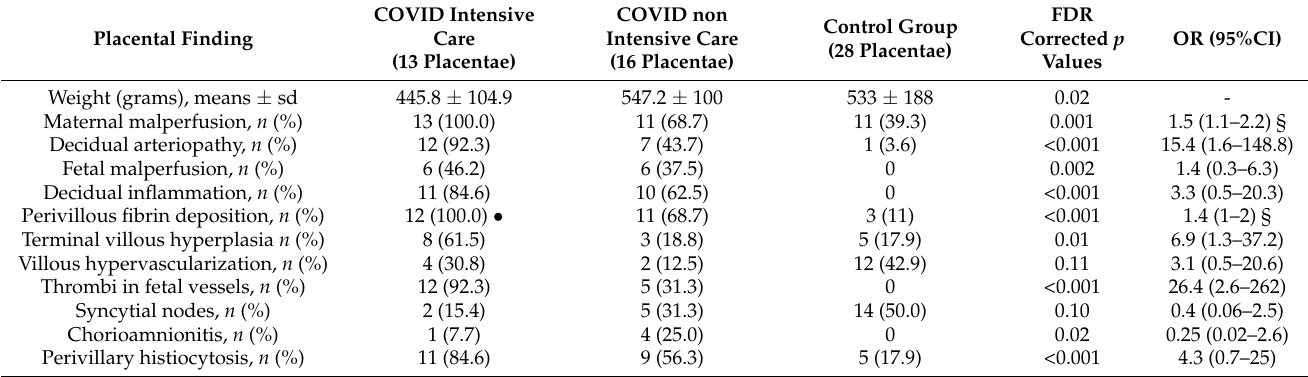
Table 2. Placental findings in COVID intensive care, COVID not intensive care and control groups.